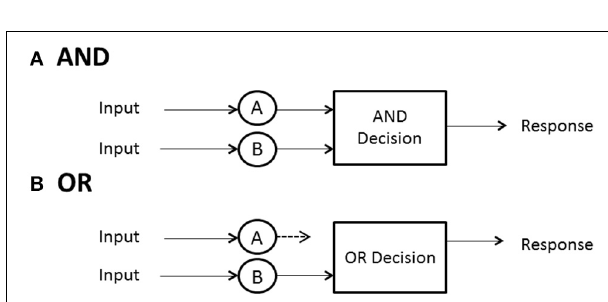
FIGURE 3 | Depiction of stopping rules in a parallel system: (A) AND, (B) OR.